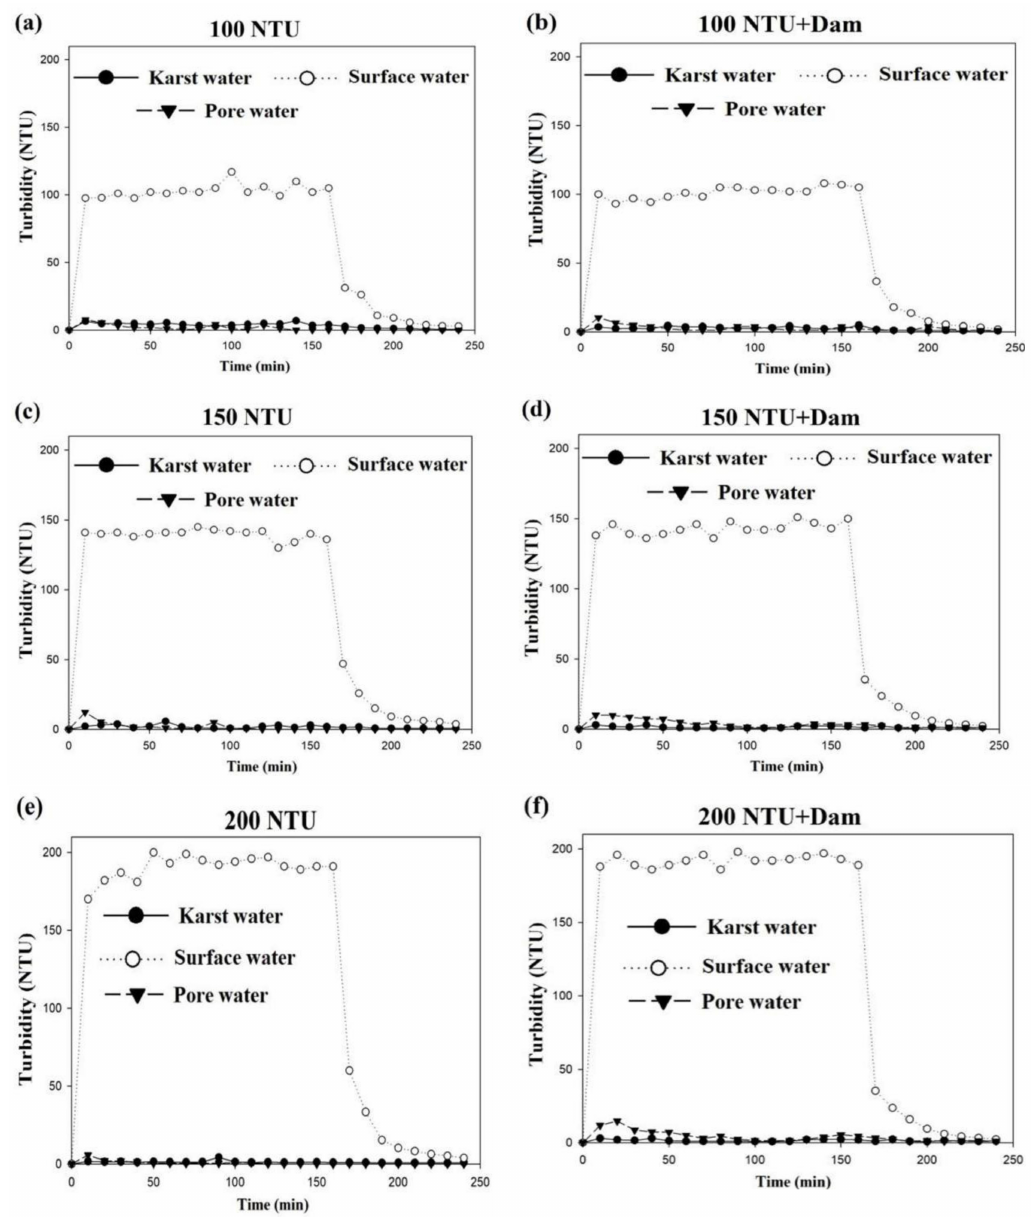
Figure 9. ( a , c , e ) Turbidity curves of surface water, pore water, and karst water when the turbidity of recharge water is 100, 150, and 200 NTU, respectively. ( b , d , f ) Turbidity curves of surface water, pore water, and karst water when the turbidity of recharge water is 100, 150, and 200 NTU, respectively, after the rubber dam is built in the